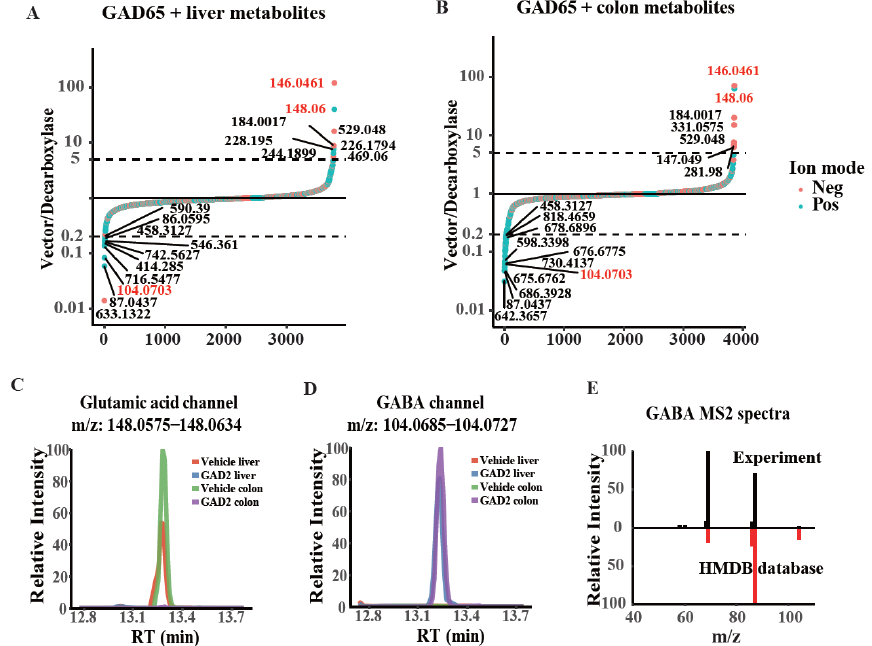
Figure 5. Detection and analysis of the substrate and product of GAD65 with tissue metabolites. ( A , B ) LC-MS untargeted metabolomic results for enriched Vector and GAD65 subjected to enzy- matic reaction with liver metabolites ( A ) and colonic metabolites ( B ). The signal ratio between the vector and decarboxylase sample was plotted. Metabolite depleted in the decarboxylase sample showed a higher vector/decarboxylase ratio. ( C , D ) Ion chromatograms of glutamate ( C ) and GABA ( D ). ( E ) Experiment and database MS2 spectra confirmed the new peak was GABA. 3. Discussion Our present work provides a simple and efficient method for the identification of the substrate and product of an amino acid decarboxylase. Through the eukaryotic protein expression system, immunoprecipitation protein purification, and in vitro enzymatic re- action with complex metabolite mixtures and LC-MS detection, we validated our method by identifying both the substrate and product for the amino acid decarboxylase GAD65. Combining the eukaryotic expression system and the immunoprecipitation protein puri- fication allows for the method to be adapted to various proteins of interest. Using the tissue extract to serve as a metabolite pool in the in vitro enzymatic reaction was the high- light of our method. Instead of testing metabolites one by one, the tissue extract contained more diverse metabolites, which significantly increases the scope of tested metabolites. It may be more important to study decarboxylases with tissue-specific expression, as the corresponding tissue extract is more likely to contain the enzyme’s substrates. In addition, we observed that metabolites similar to the known substrates of the enzyme showed par- tial depletion, e.g. , aspartate in the GAD65 reaction (Figure 4), which suggested that our method is suitable to identify other potential substrates with the presence of the main substrate. By leveraging the high resolution and sensitivity of LC-MS, our method has high efficiency and specificity to identify changing metabolites in the complex system. In conclusion, our method is poised to identify substrates and products for other novel amino acid decarboxylases, which will shed light on the understanding of their biological functions.